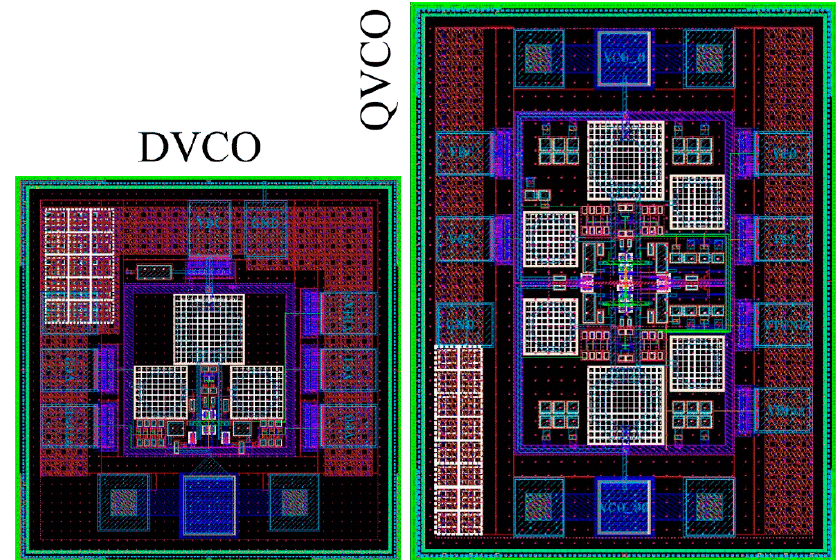
Figure 6. Physical layouts of the designed oscillators. Electronics 2018 , 7 , x FOR PEER REVIEW